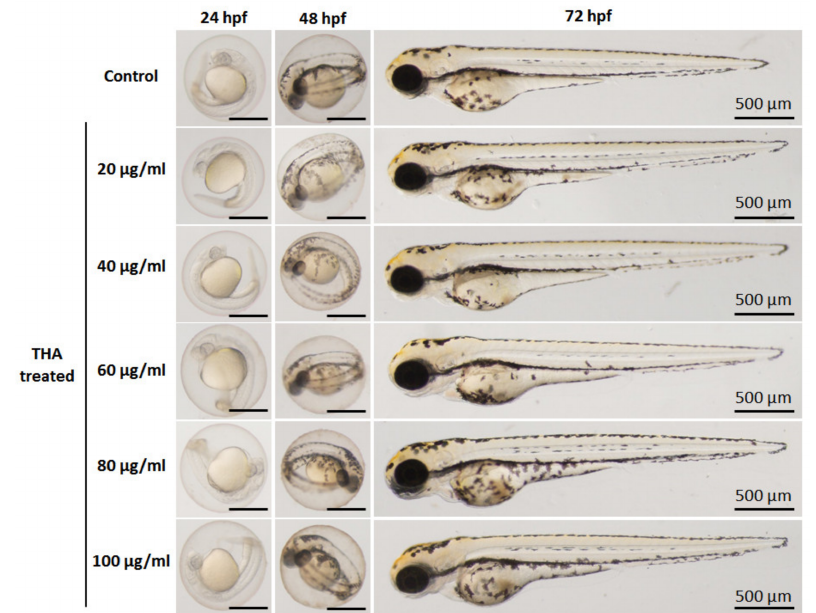
Figure 12. Digital photographs of zebrafish embryos at different stages of growth in solutions exposed to different concentrations ( µ g/mL) of THA powder at 24, 48, and 72 hpf.